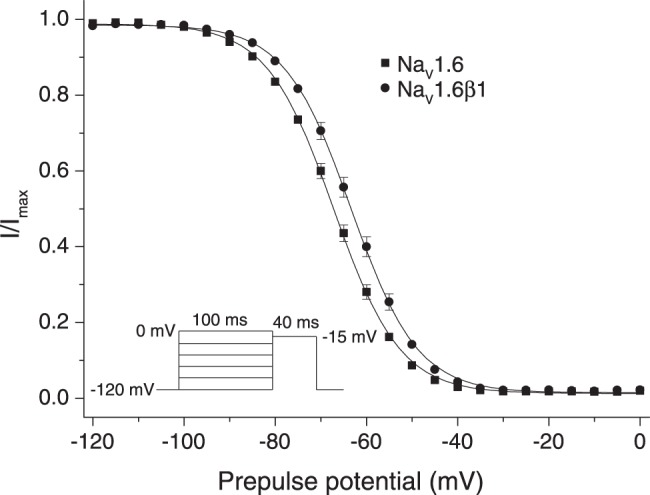
Voltage-dependent steady-state fast inactivation of Nav1.6 and Nav1.6β1 sodium channels expressed in HEK293 cells.Amplitudes of peak transient currents obtained using the indicated pulse protocol are plotted as a function of prepulse potential. Values are means of 63 (Nav1.6) or 66 (Nav1.6β1) separate experiments with different cells; bars show SE values larger than the data point symbols. Curves were fitted to the mean values using the Boltzmann equation.